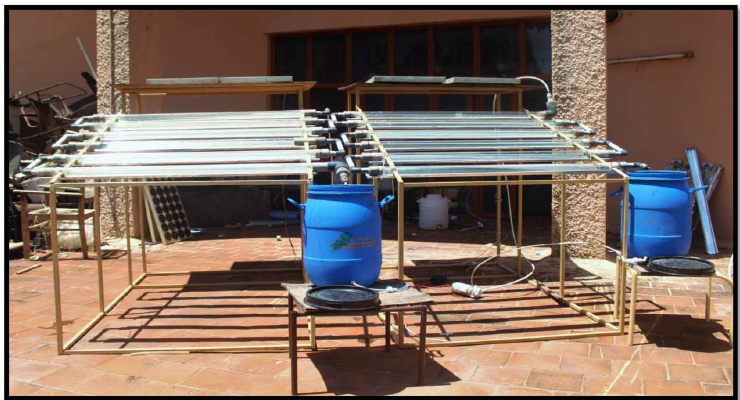
Figure 24. Fixed-bed tubular reactor for purification of rainwater. (Reprinted/adapted with permis- sion from Ref.